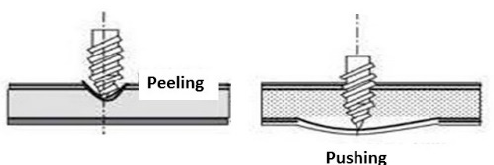
Figure 21. Delamination damage mechanisms of drilling. Adapted from [68].